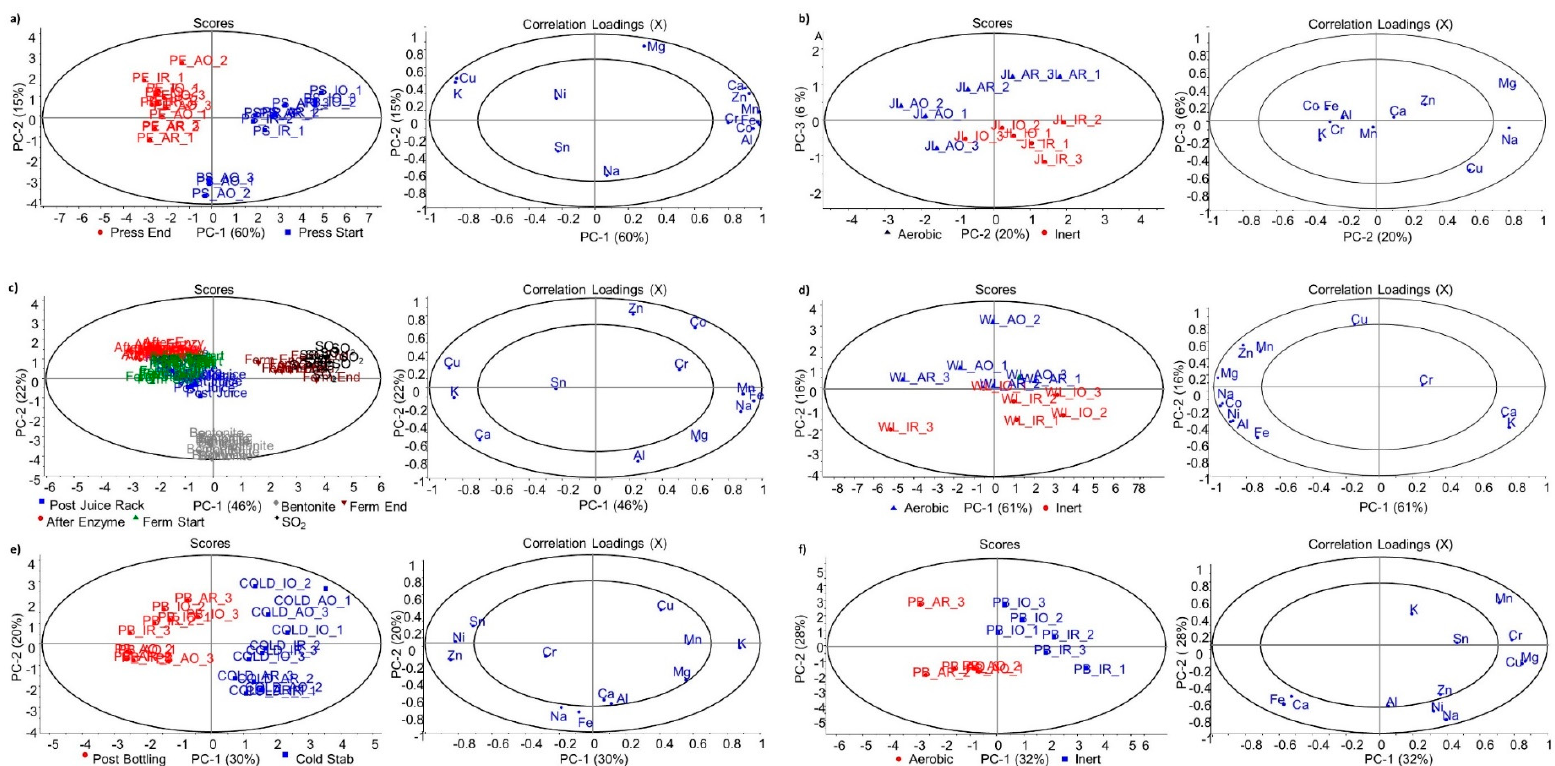
Figure 1. Principal component analysis (PCA) plots summarizing the differences in metal ion concentrations ( x correlation loading plots) in Chardonnay juice, wine, and lees samples (scores plots) measured at the following time points: ( a ) juice supernatant collected at the start of press (blue) and the end of press (red); ( b ) juice lees (grape solids) collected after juice racking grouped according to the aerobic (blue) and inert pressing regime (red); ( c ) supernatant collected during fermentation, with wines grouped by samples collected after juice racking (blue), after enzyme addition (red), after the start of the ferment (green), after the end of ferment (brown), after SO 2 addition and racking (black), and after bentonite addition (grey); ( d ) wine lees collected after racking with lees grouped by aerobically (blue) and inertly pressed (red) wines; ( e ) finished wines with samples grouped by those collected after cold stabilization (blue) and post-bottling (red); and ( f ) post-bottling wines grouped according to the aerobic (red) and inert (blue) pressing regime.